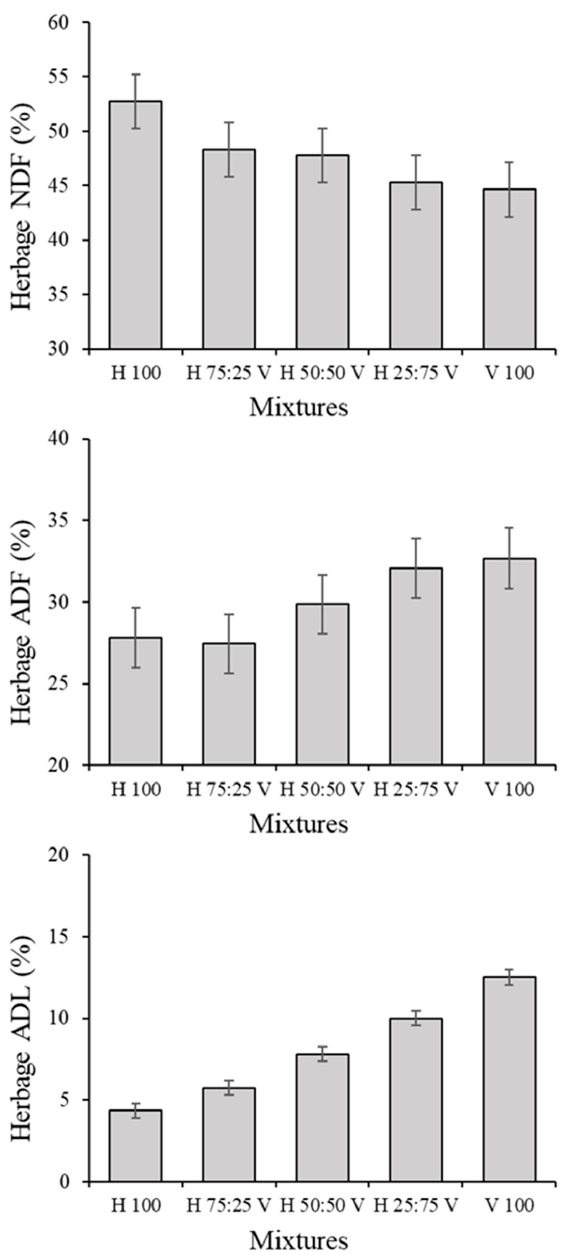
Figure 5. Herbage NDF ( above ), ADF ( middle ) and ADL ( below ) concentrations as affected by mean effect MX. Values are LSmeans across all treatments along with standard error estimate of the LSmeans since the design was unbalanced between the faba bean crop ( n = 9) compared to the mixtures and the barley crops ( n =